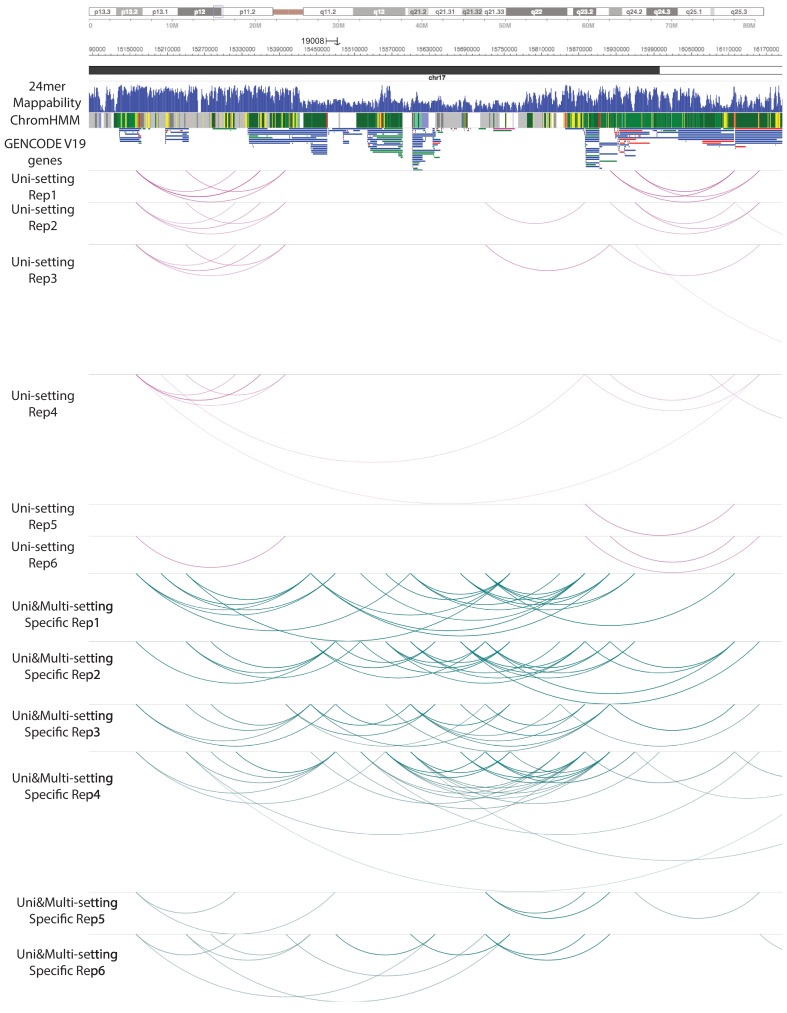
Significant promoter-emhancer interactions under Uni- and Uni&Multi-settings across 6 IMR90 replicates (Chromosome 17).This is the individual replicate level data for Figure 4—figure supplement 2 in a large genome region.